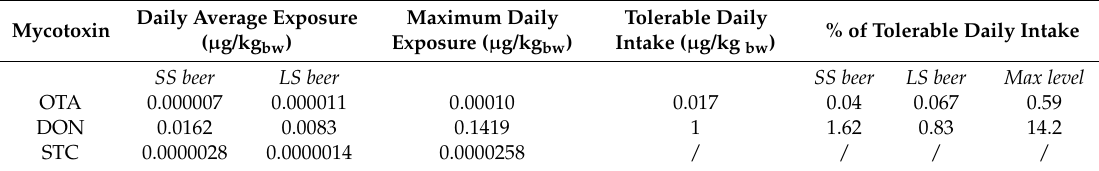
Table 2. Estimation of mycotoxin dietary intakes from small- (SS) and large-scale (LS) brewed beer consumed in